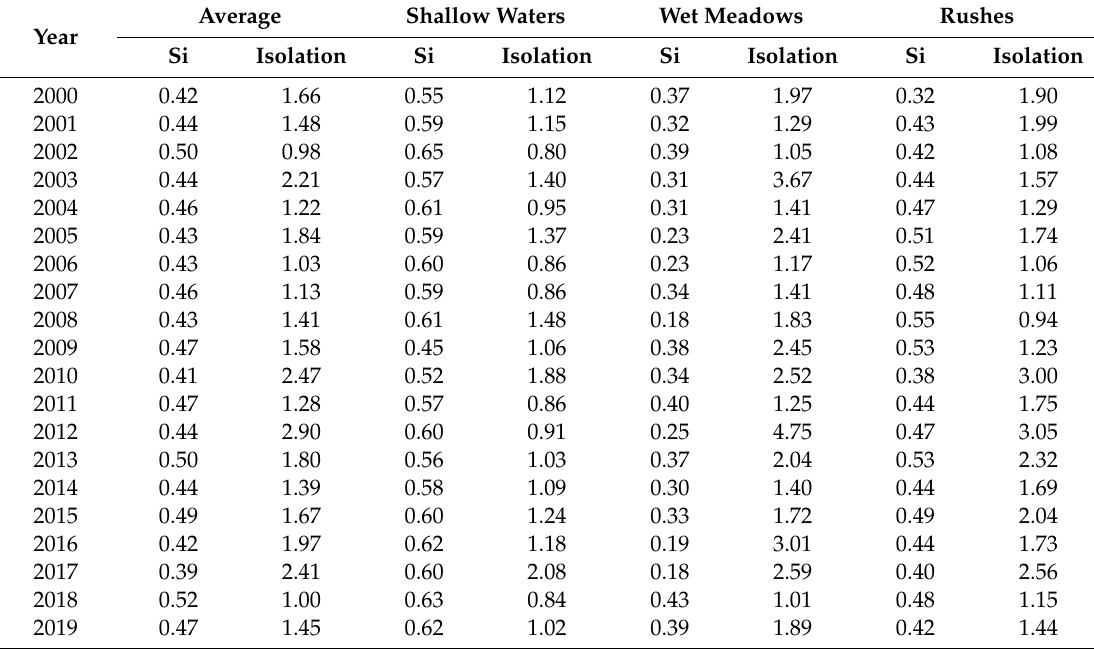
Table 3. Silhouette width (si) and isolation index for the CLARA (Clustering Large Applications) clustering. Average Shallow Waters Wet Meadows Rushes Year